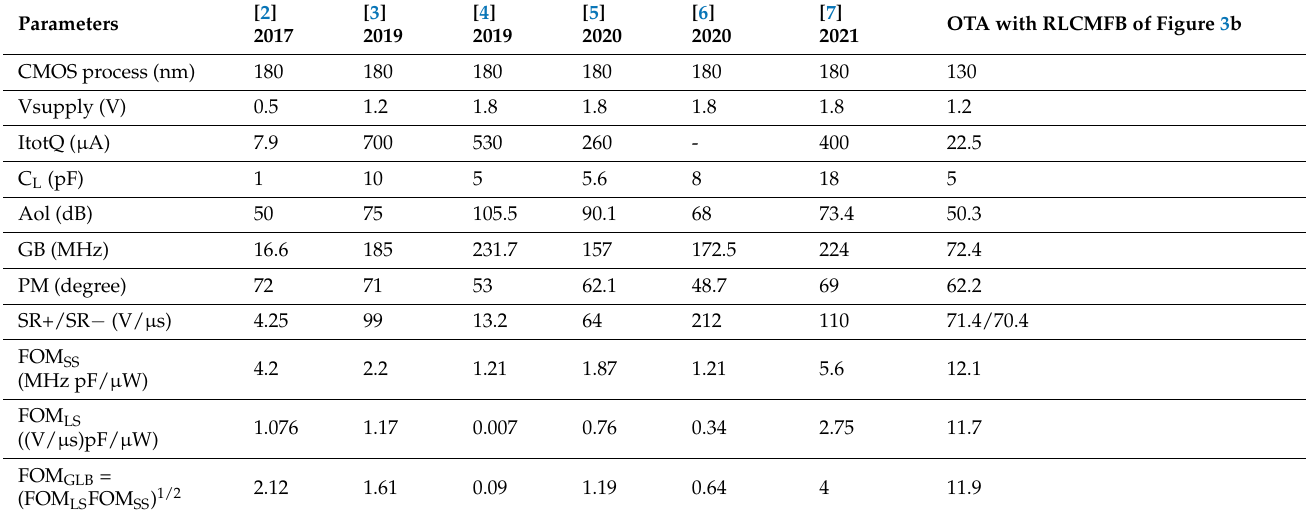
Figure 9. Negative PSRR of the circuits of Figure 3. Table 3. Comparison of performance characteristics of OTA of Figure 3b to other OTAS in the